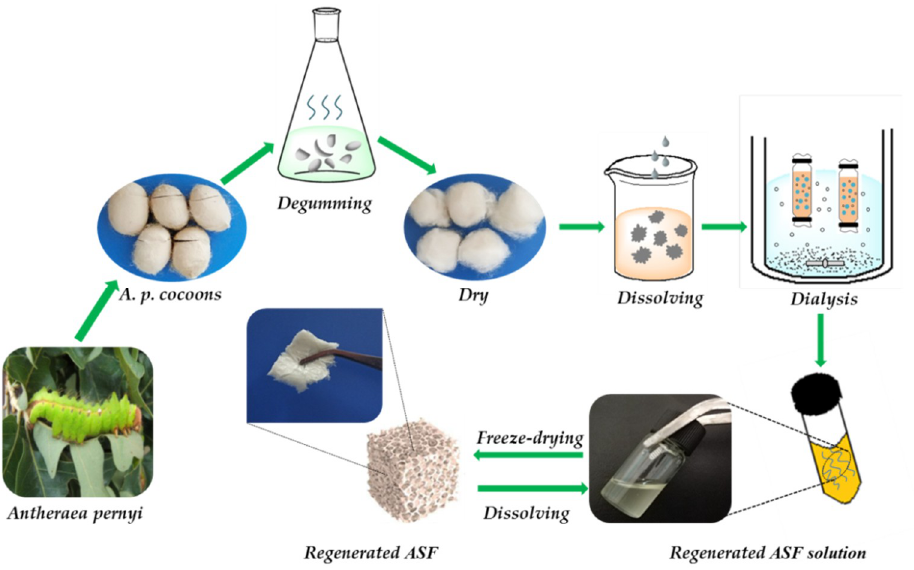
Figure 1. Preparation of regenerated ASF.